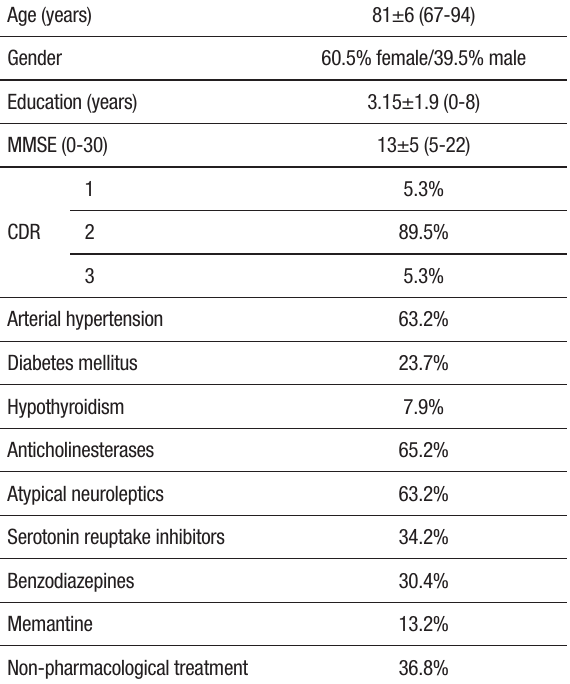
Table 1. Characteristics of sample with Alzheimer’s disease.